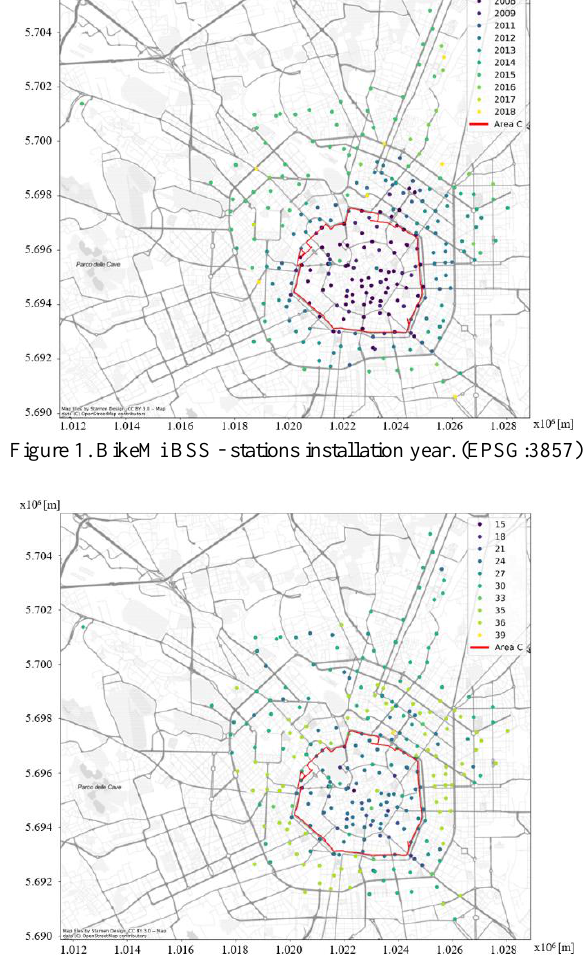
Figure 2. BikeMi BSS - number of docks per station.